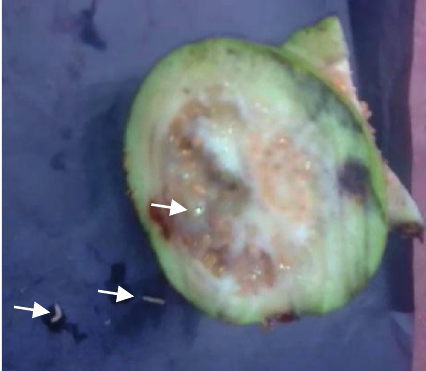
Figure 1: Guava fruit with fly